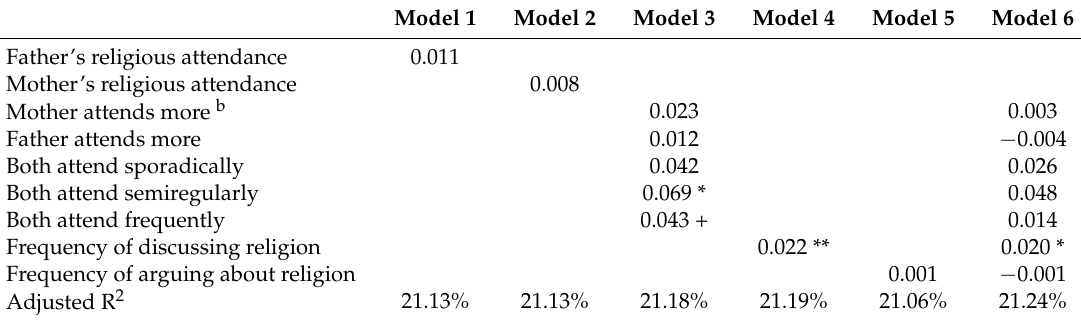
Table 4. Unstandardized coefficients predicting children’s interpersonal skills (teachers’ ratings, n = 10,720) a .